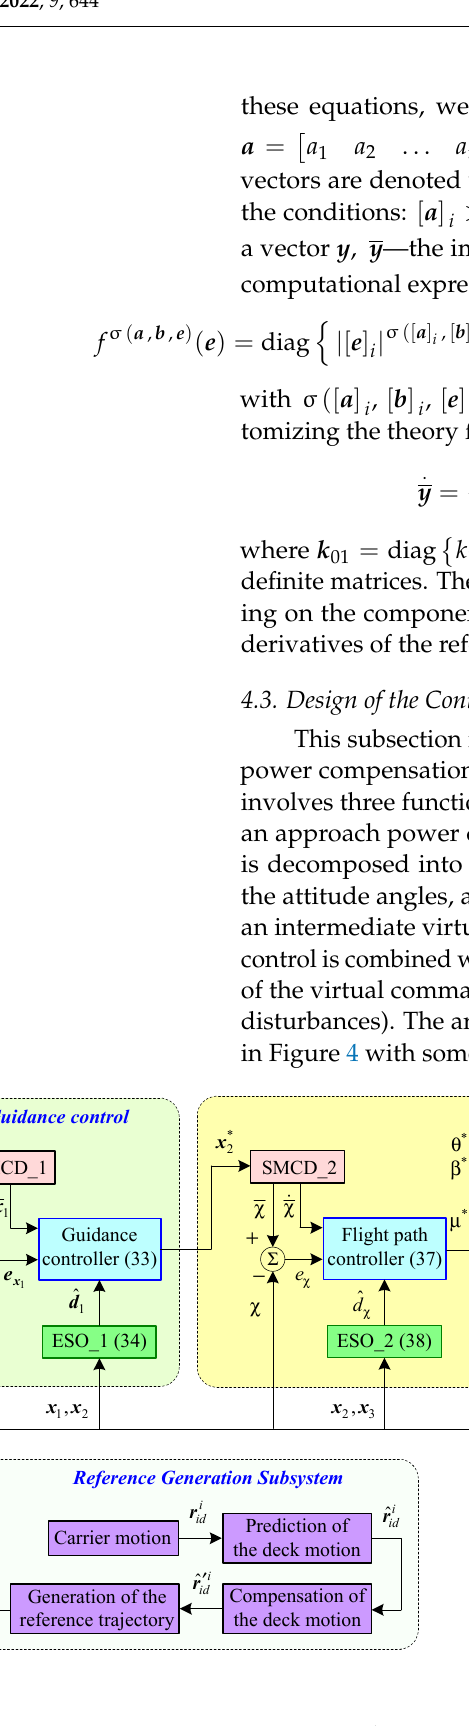
Figure 4. Architecture of the automatic carrier landing system.